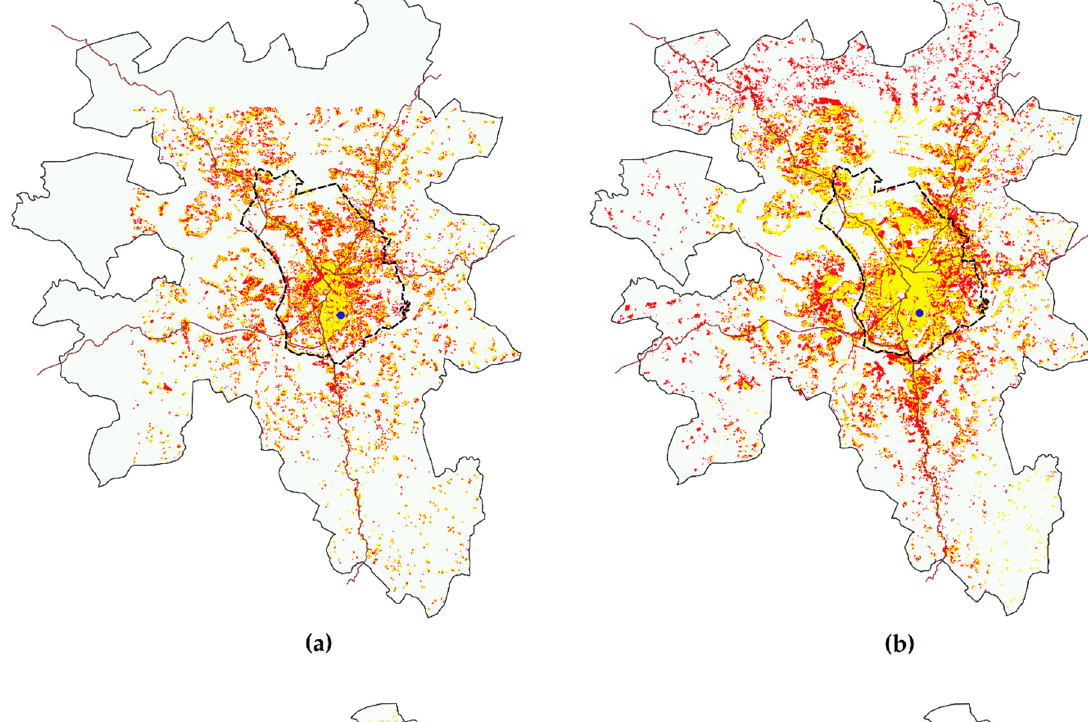
where most constructions were arranged along the main national axes (Figures 8 and 9).